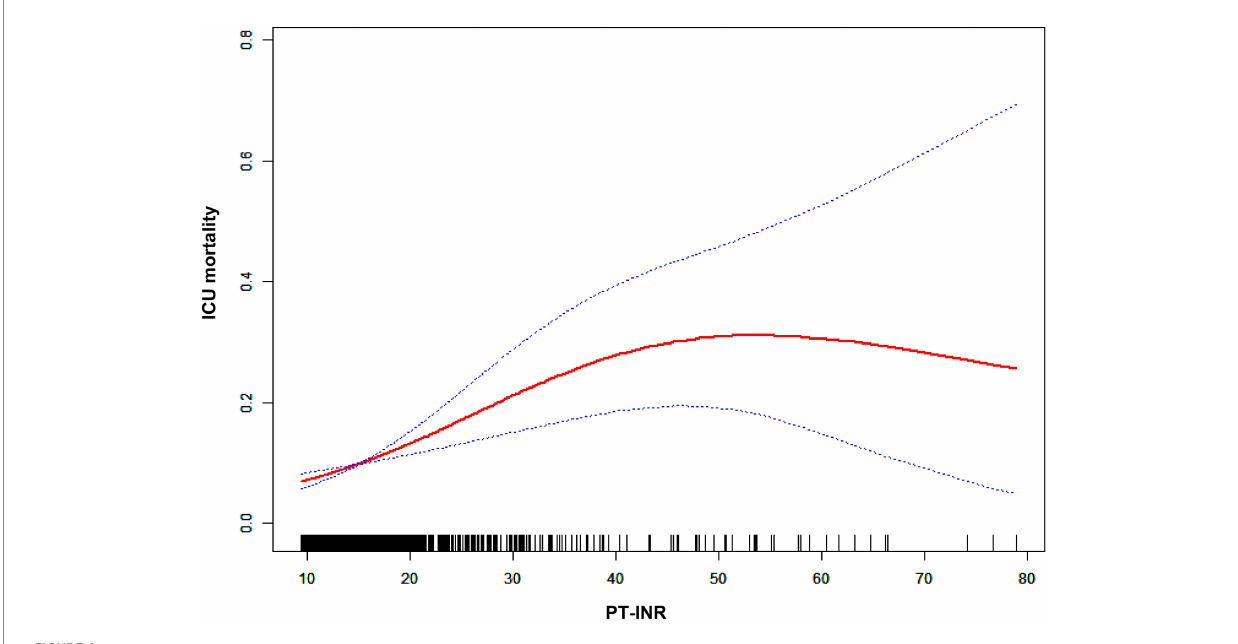
FIGURE 4 Nonlinear relationship between the PT count and in-hospital